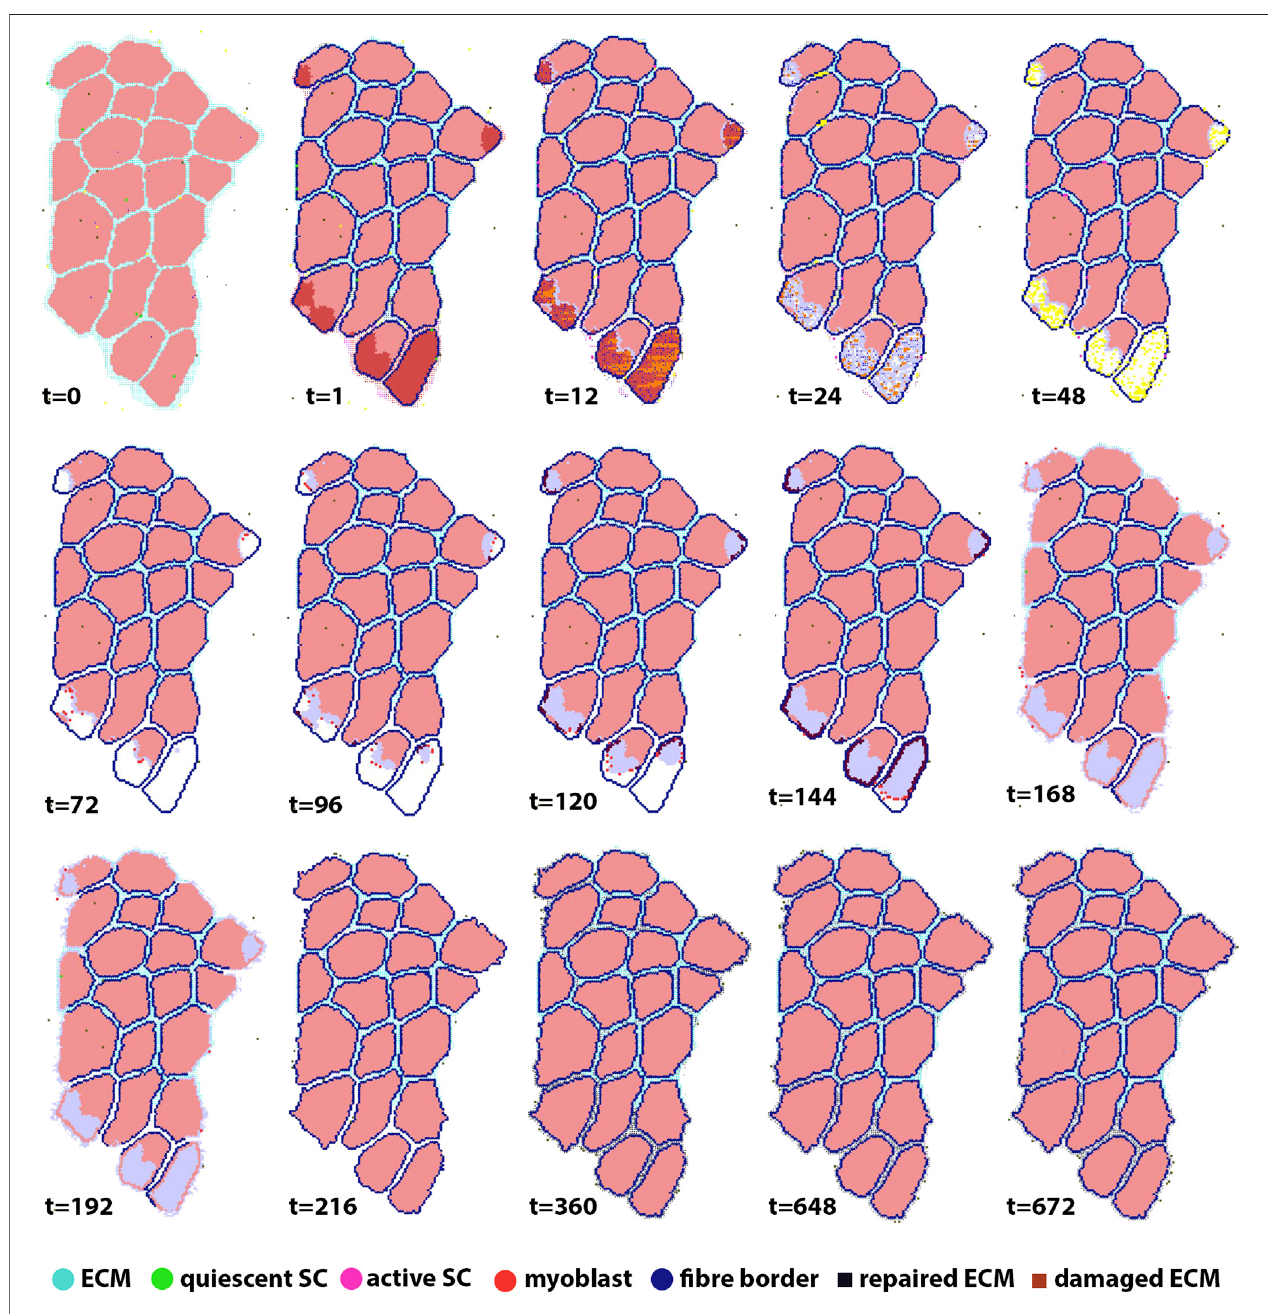
FIGURE 5 | ABM simulation of muscle regeneration over time. At the fi rst time point, regions of the muscle fi ber bundle show damage. This damage signals for the mobilizationofmacrophages,neutrophils,satellitecellsand fi broblasts,whichinteractinthemuscleregenerationprocess.Notethatthedominantchangefrom t (cid:2) 216to t (cid:2) 672 is ECM